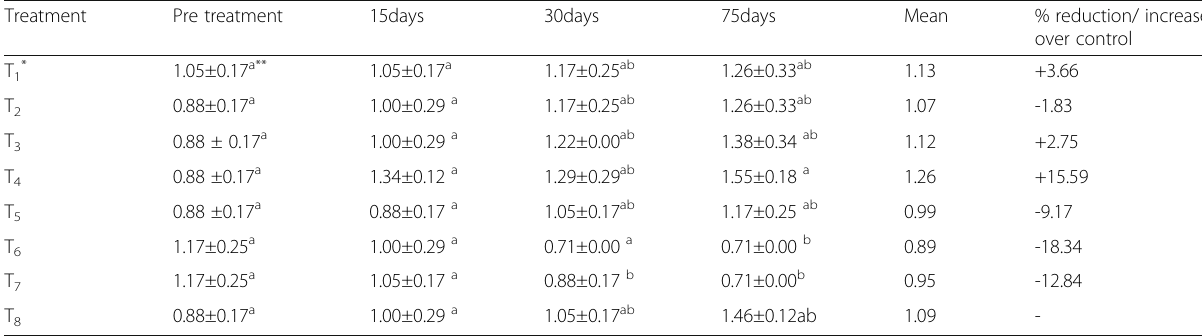
Table 5 Effect of insecticides on earthcast (per 0.5 m 2 area in field) at different intervals Treatment